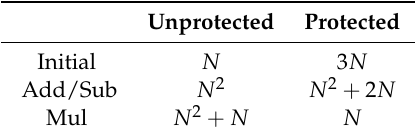
Table 1. Comparison of Operation between Unprotected and Protected NTRUEncrypt.